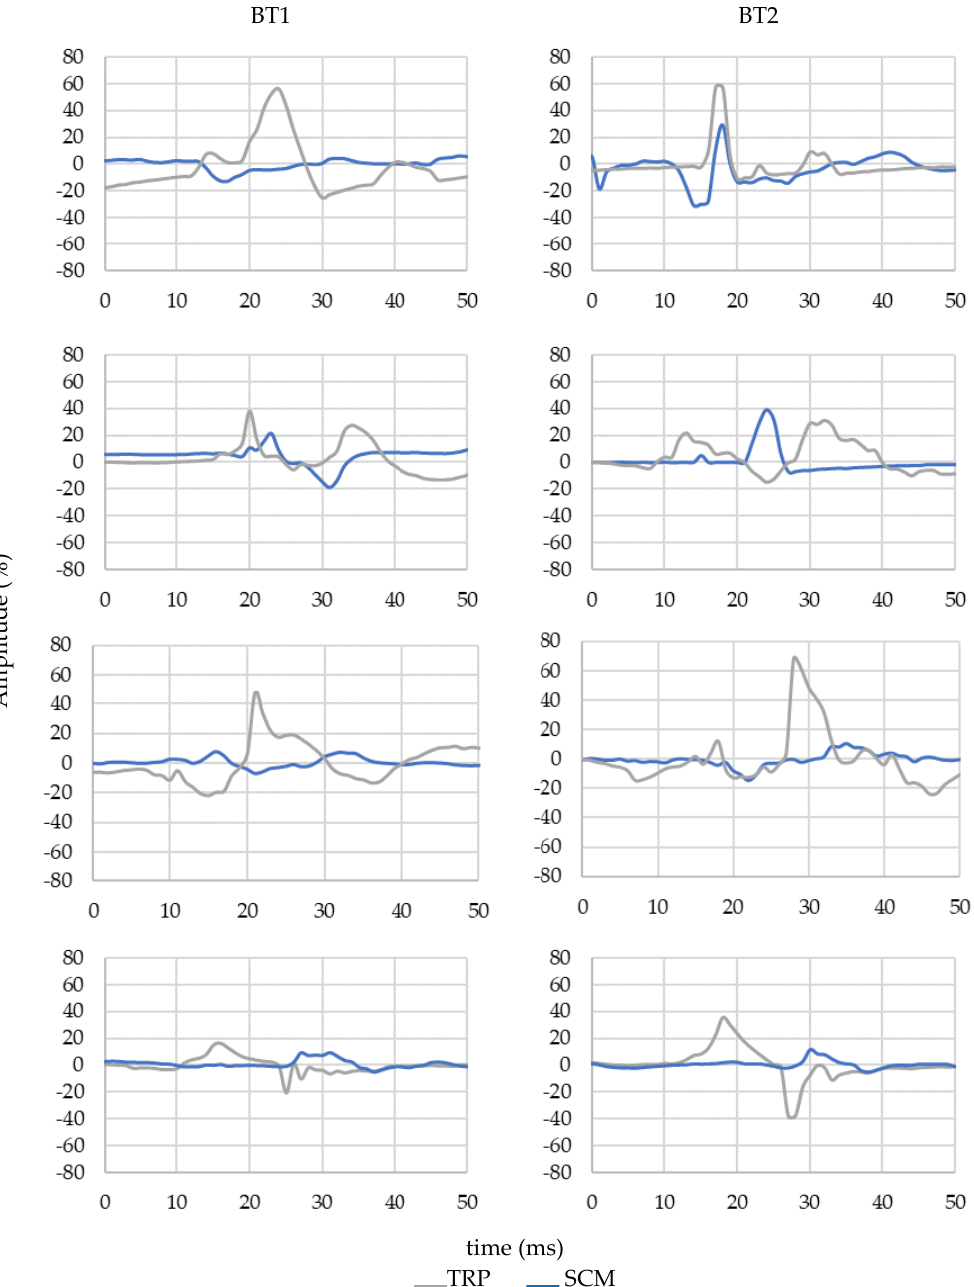
Figure 8. Normalised sEMG signal of four volunteers from the SCM and TRP muscle. First row: Man, 31 years old, 185 cm height, 70 kg. Second row: Woman, 41 years old, 172 cm height, 78 kg. Third row: Man, 39 years old, 189 cm height, 80 kg. Fourth row: Woman, 32 years old, 162 cm height, 47 kg. Left column: Emergency test braking 1. Right column: Emergency test braking 2.